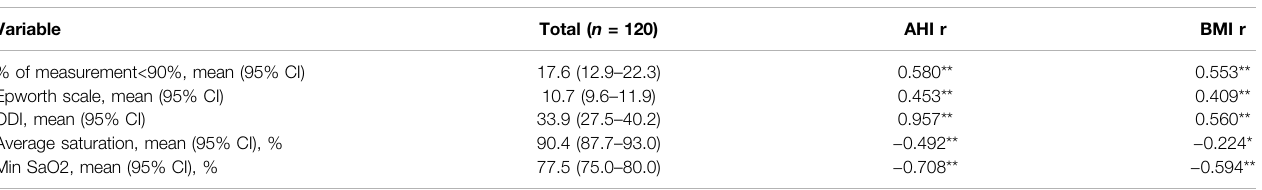
TABLE 3 | Respiratory parameters of the study population and their correlation with AHI and BMI.